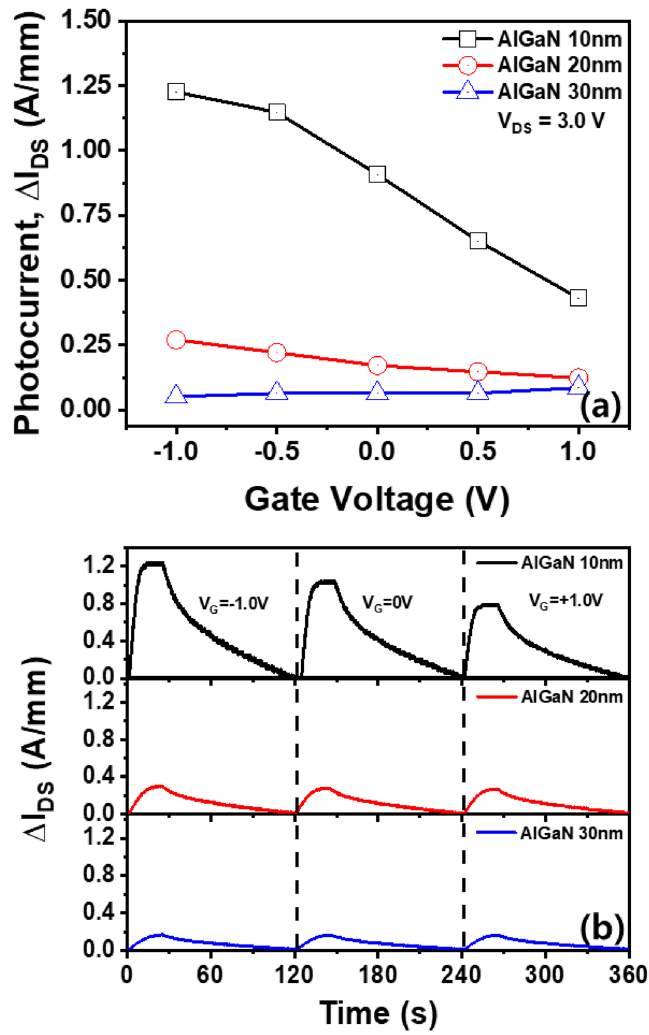
Figure 5. Photocurrent characteristics of HEMTs with ( a ) 10 nm, 20 nm, and 30 nm thick AlGaN barriers at the applied gate voltage of 3.0 V as a function of different AlGaN barrier thicknesses. ( b ) Time-dependent photocurrents of HEMTs with different AlGaN barriers; each duration was applied a different gate voltage (V G = − 1.0 V for 0–120 s, V G = 0 V for 120–240 s, and V G = + 1.0 V for 240–360